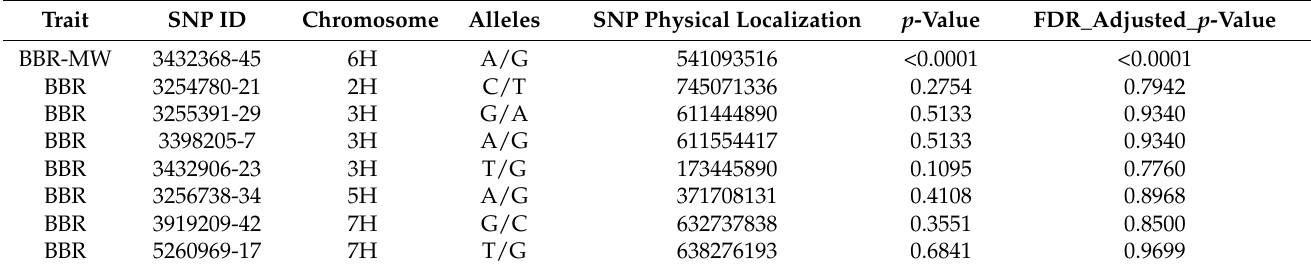
Table 5. Significant marker–trait associations (MTAs) for resistance to BBR MW seeds stage and maximum disease scored across all replicates